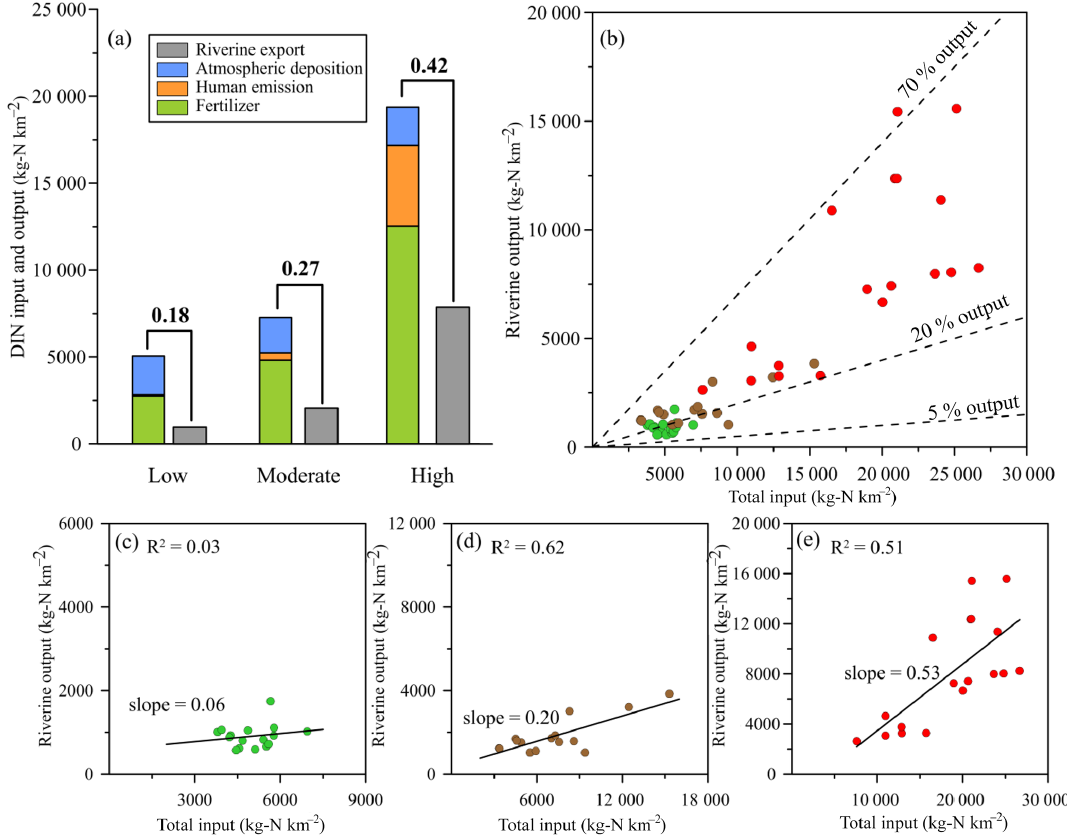
Figure 7. Nitrogen input and riverine output in the low, moderately, and highly disturbed watersheds (a) . Riverine DIN export against the total nitrogen input (b) . The regressive slope of riverine output for the low disturbed (green dots) (c) , moderately (brown dots) (d) , and highly disturbed (red dots) (e)